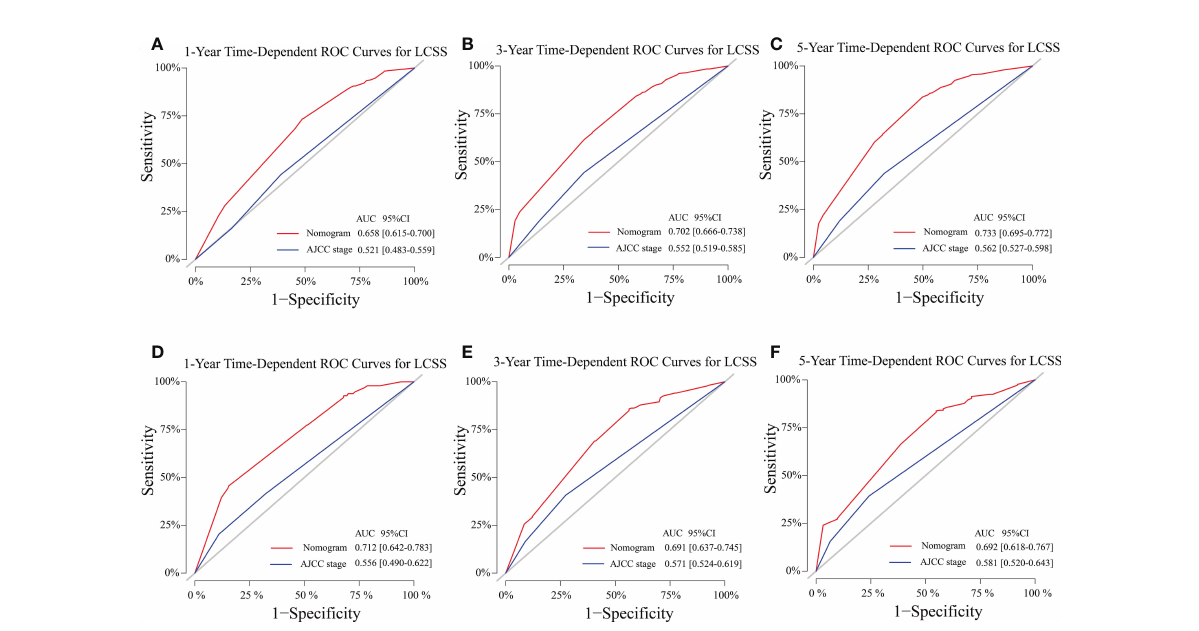
FIGURE 4 Model performance of the proposed nomogram. (A – F) Time-dependent ROC curves of the two prognostic models for predicting 1-, 3-, and 5- year LCSS. The AUCs of the two prognostic models at each time point of interest were presented in the training (A – C) and validation cohorts (D – F) . ROC, receiver operating characteristic; AUC, area under the curve; LCSS, lung cancer-speci fi c survival; AJCC American Joint Committee on Cancer; CI con fi dence